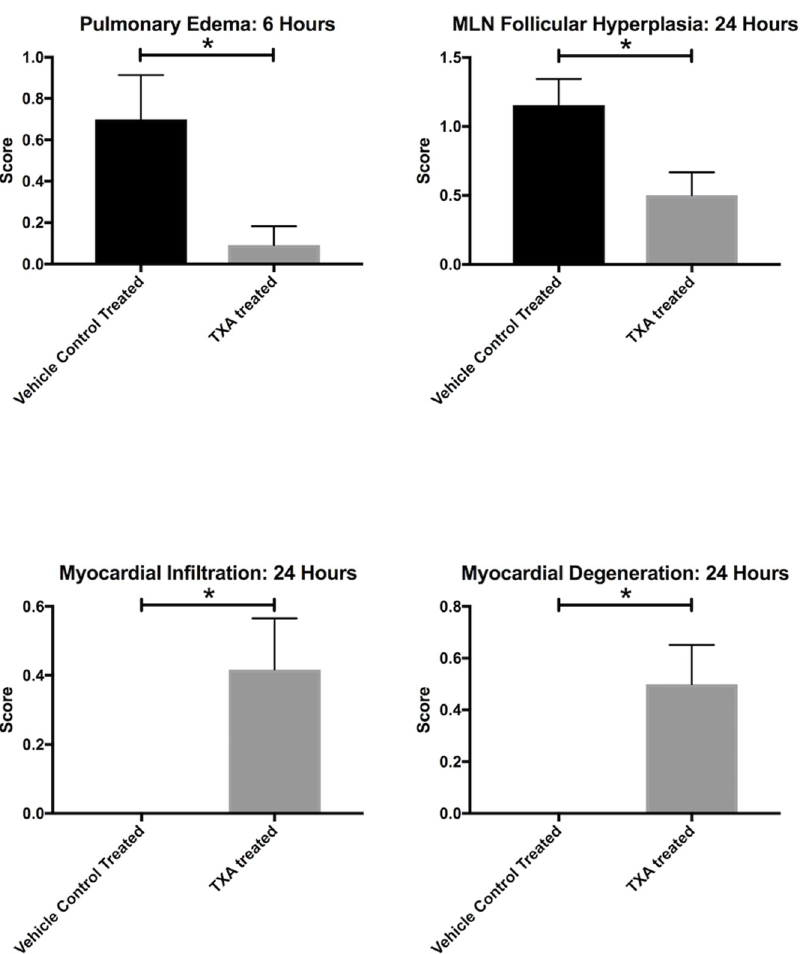
Fig 5. Mean histopathologic scoring of lung, mesenteric lymph node (MLN), and myocardial tissue in rats subjected to controlled hemorrhagic shock and resuscitation, vehicle control (normal saline) treated vs. tranexamic acid (TXA) treated, 300mg/kg ( � p < 0.05, error bars = SEM).